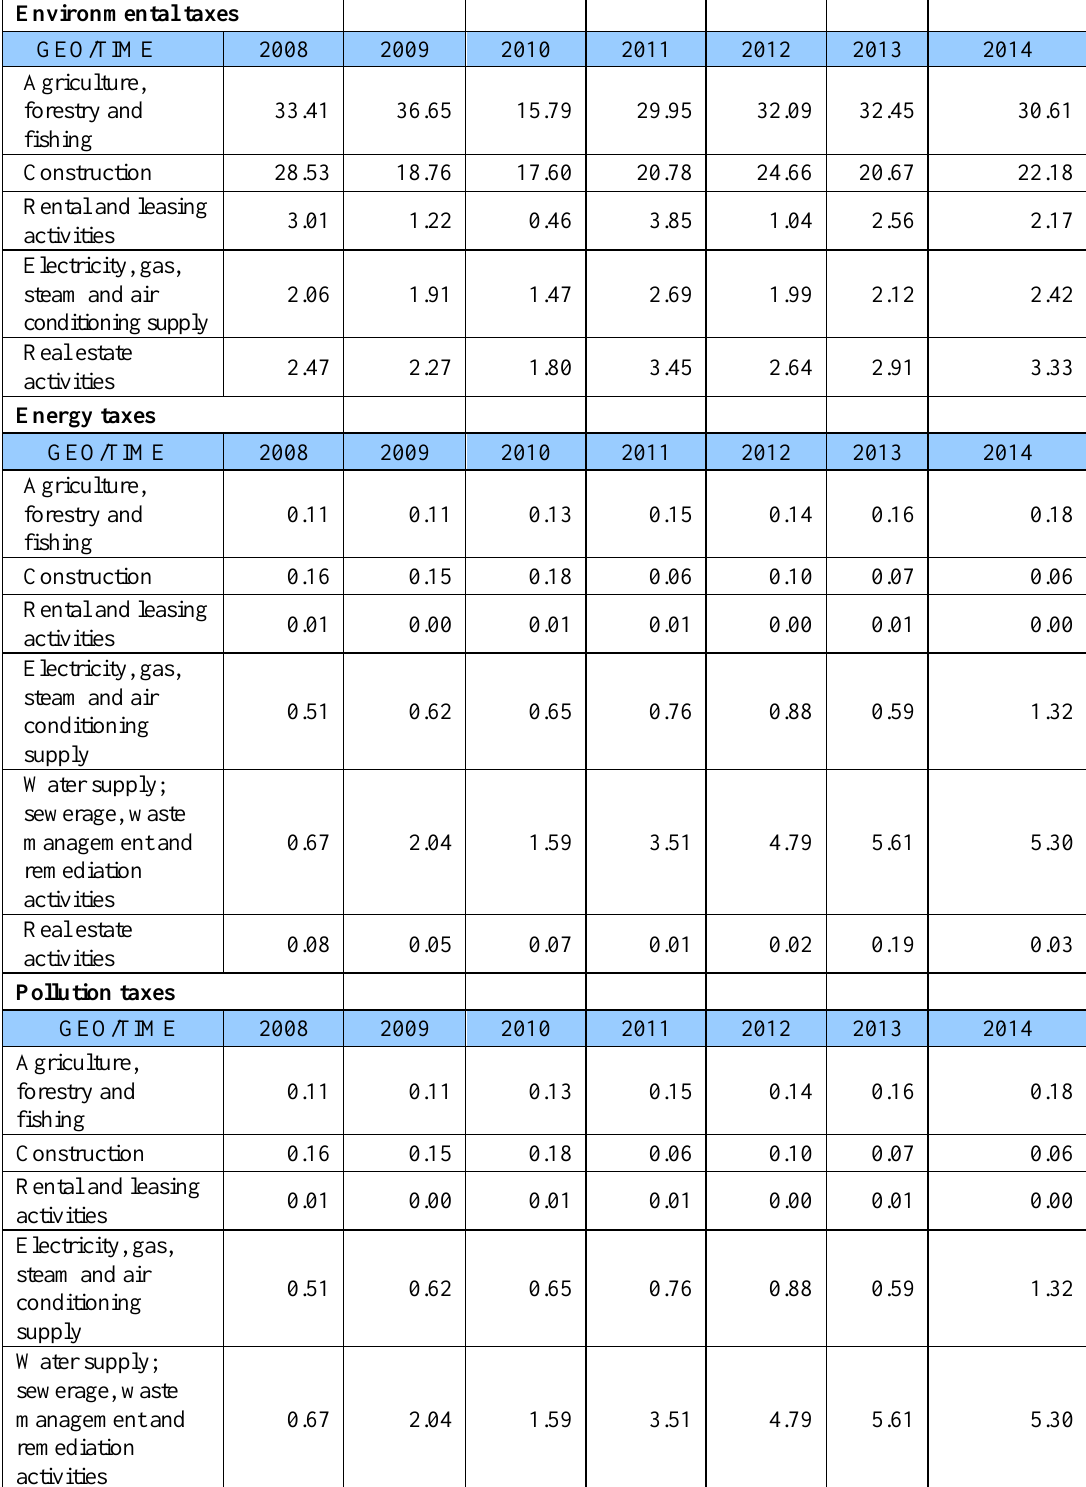
Table 4. Environmental tax revenues in Latvia, MEuro. Data: Eurostat (n. d.) (last available data on September 10, 2017) [developed by